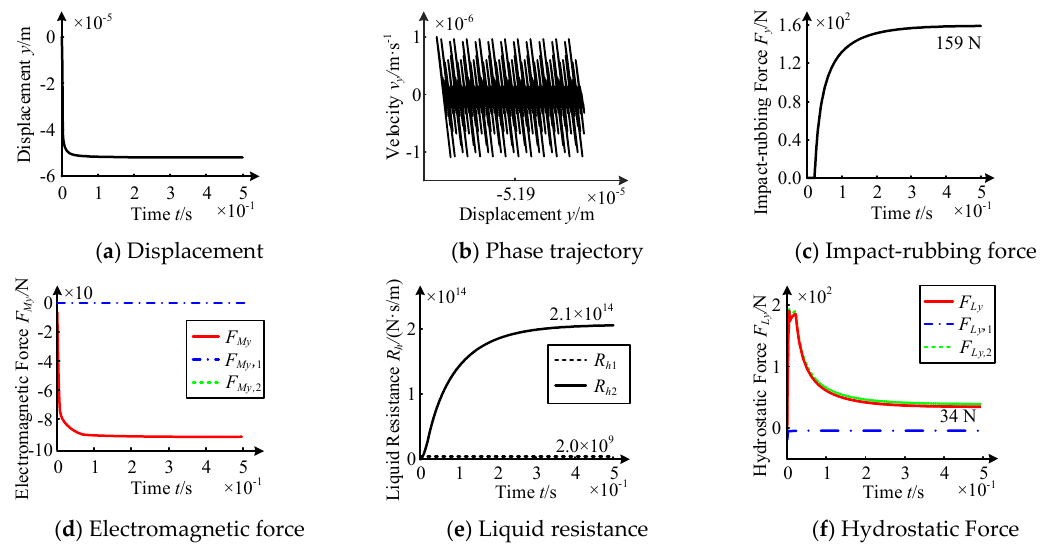
Figure 17. Operating law under upper unit failure.